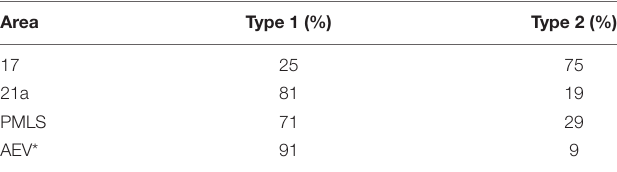
TABLE 1 | Percentage of CT terminal types as a function of cortical source for areas 17, PMLS, 21a and AEV in